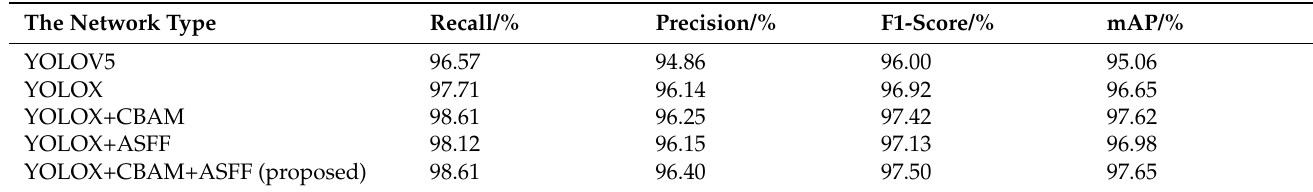
Table 2. Detection results of different YOLO improvement methods (IoU threshold is